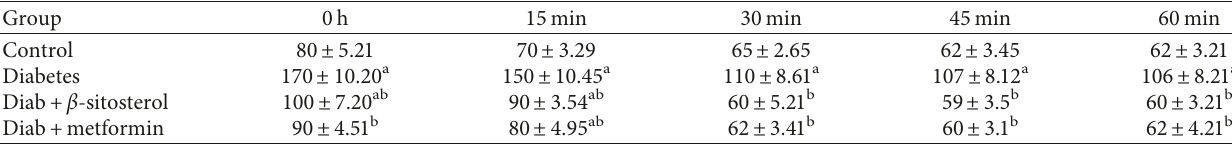
Table 3: The effect of β -sitosterol on ITT in control and diet-fed diabetic rats. Group